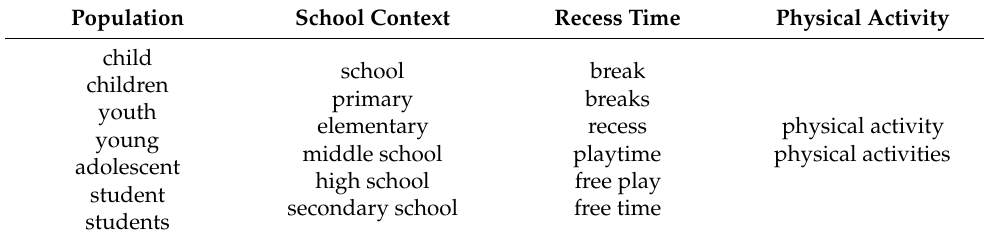
Table 1. Systematic review categories and search